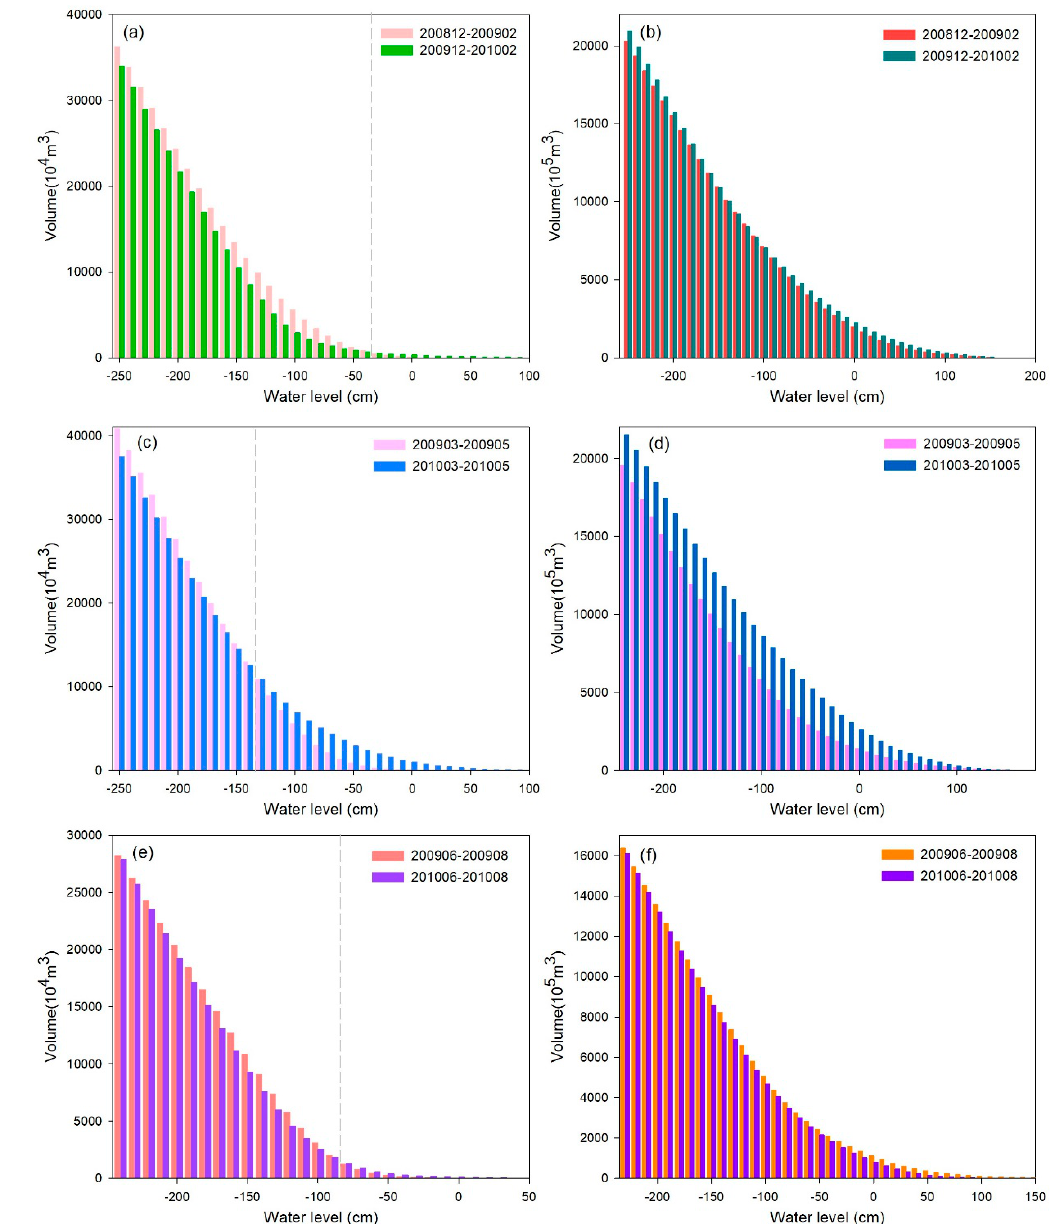
Figure 6. Intra-annual patterns of tidal flats in aquaculture and non-aquaculture regions of the study area. During winter 2008 vs winter 2009, respectively in ( a ) aquaculture and ( b ) non-aquaculture regions; During spring 2009 vs spring 2010, respectively in ( c ) aquaculture and ( d ) non-aquaculture regions; During summer 2009 vs summer 2010, respectively in ( e ) aquaculture and ( f ) non-aquaculture regions. The datum of the water levels is the mean sea level.